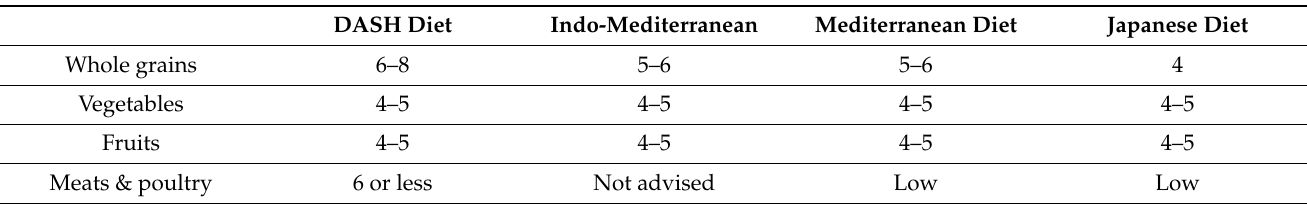
Table 2. Description of the DASH type Eating Plan (Servings) compared with other